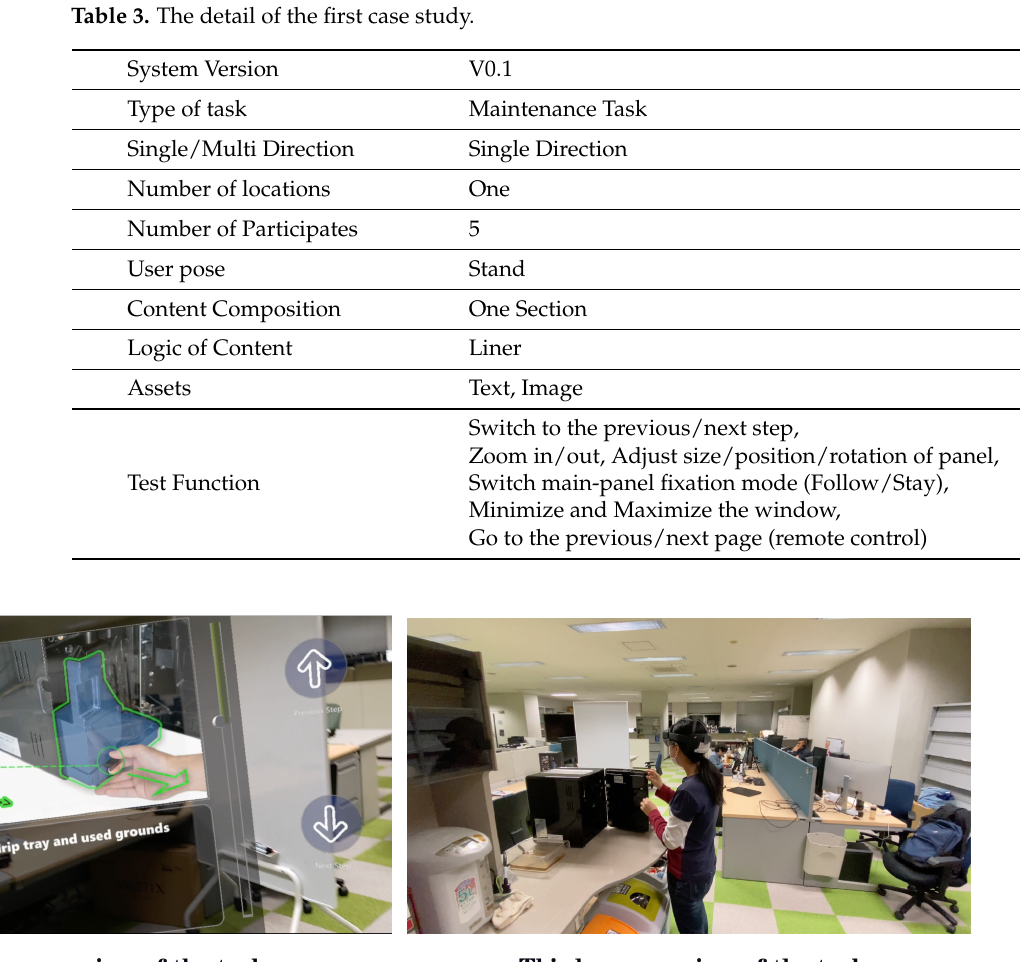
Figure 15. Case No. 1: Coffee machine maintenance